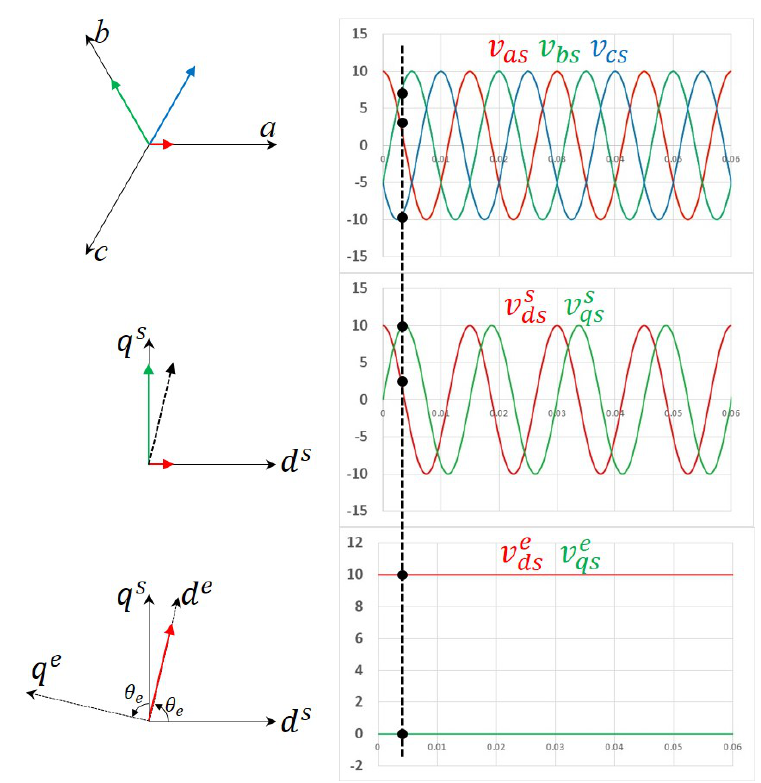
Figure 6. d-q axis